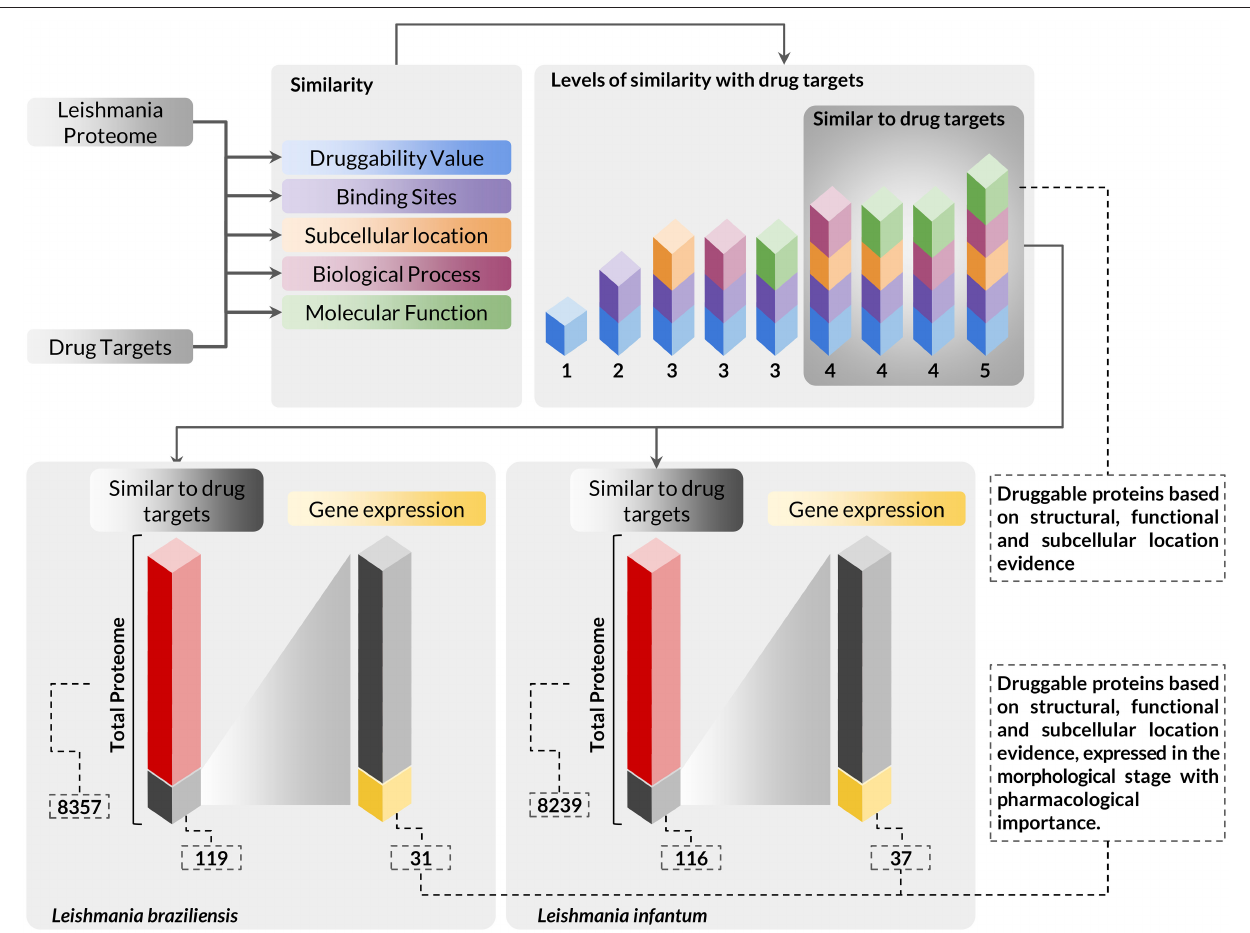
FIGURE 2 | Workflow presenting the scheme and criteria used for the selection of druggable proteins of pharmacological interest in Leishmania sp. proteomes. The complete proteome of Leishmania braziliensis and Leishmania infantum was submitted to analysis using a multidisciplinary methodology for the selection of druggable proteins based on structural, functional, and subcellular location evidence, thus identifying 119 proteins in L. braziliensis and 116 proteins in L. infantum with druggable protein criteria. The proteins selected in this context were also evaluated for the differential expression of their respective genes to verify the presence of this protein in the evolutionary stage of pharmacological interest. In this analysis, we identified that among the druggable proteins, 31 and 37 proteins of L. braziliensis and L. infantum ( Supplementary Materials 5, 6 ), respectively, had their genes positively regulated in the evolutionary stage of